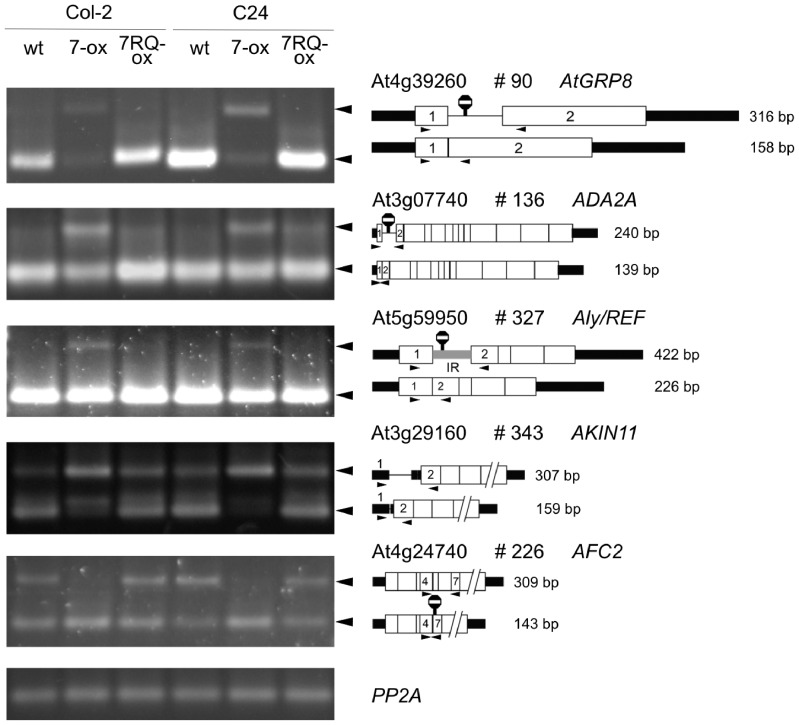
AS events in AtGRP7-ox lines not observed in AtGRP7-R49Q-ox plants. Left side: RT-PCR analysis of selected genes/transcripts with total RNA from AtGRP7-ox and AtGRP7-RQ-ox plants in both the Col-2 and C24 backgrounds and their respective wt plants. Arrowheads denote RT-PCR products representing AS events whose presence/absence or abundance differs between the over-expression lines with and without the R49Q mutation. Right side: gene and transcript structures and the AS events for AtGRP8 (#90), ADA2A (#136), Aly/Ref (#327), AKIN11 (#343) and AFC2 (#226) are shown schematically (see Figure 2). PP2A served as constitutive control.